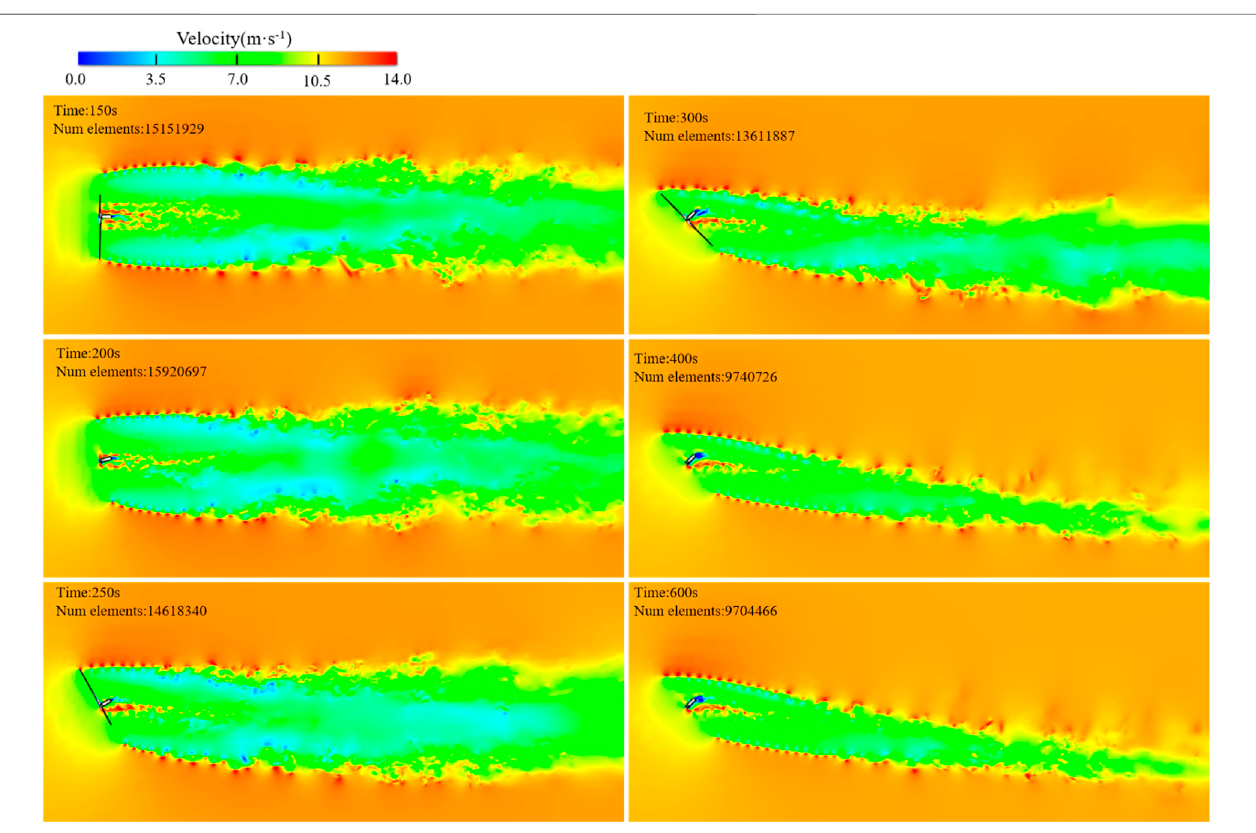
Frontiers in Energy Research |